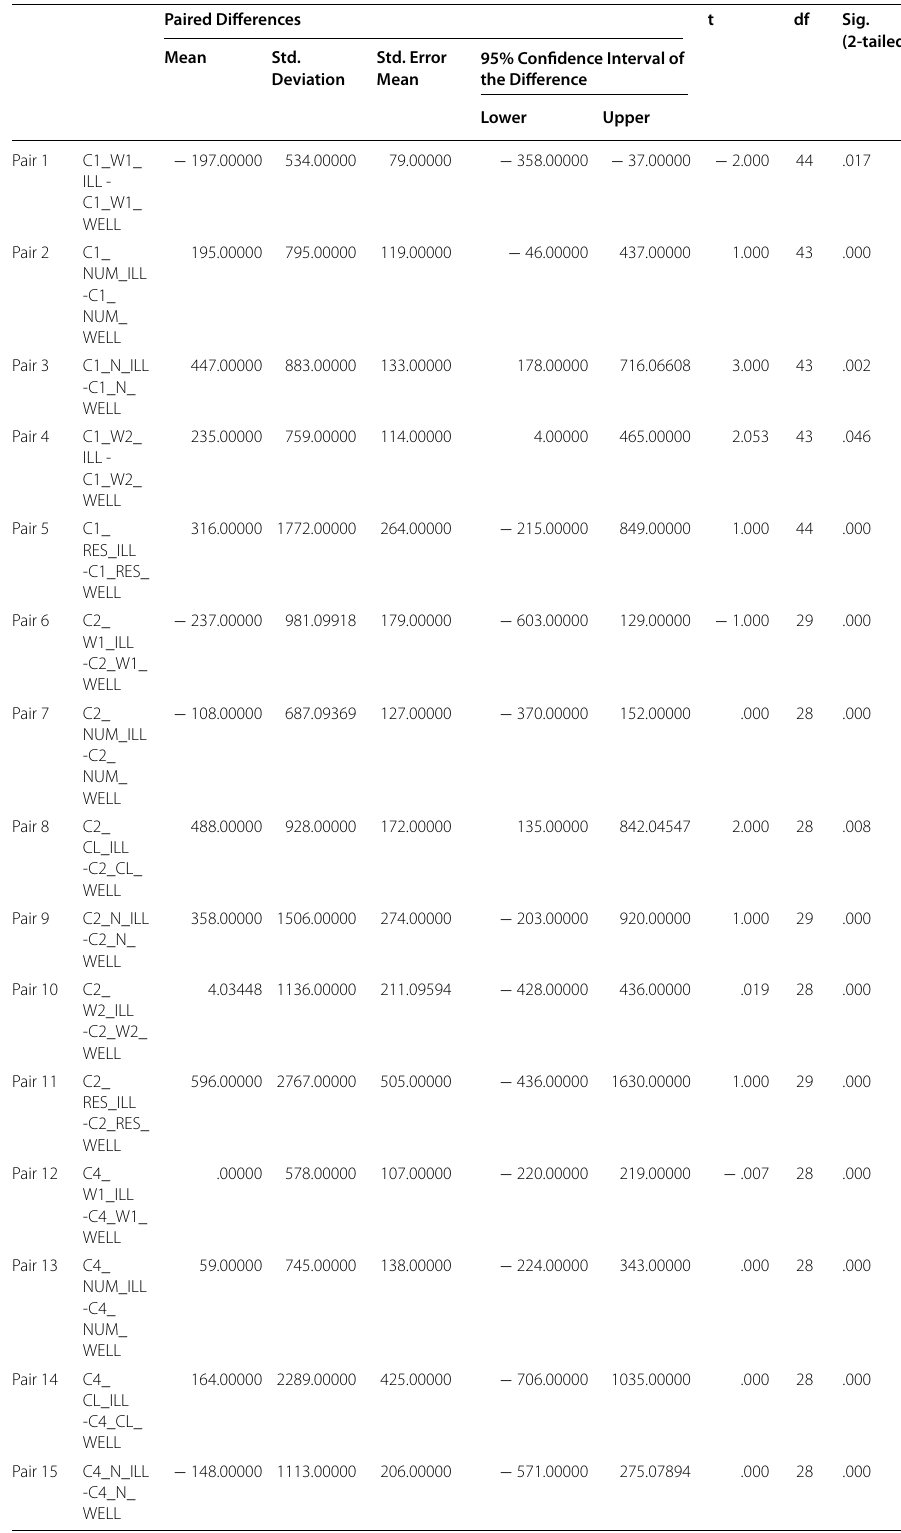
Table 12 Paired samples test (between sentence type